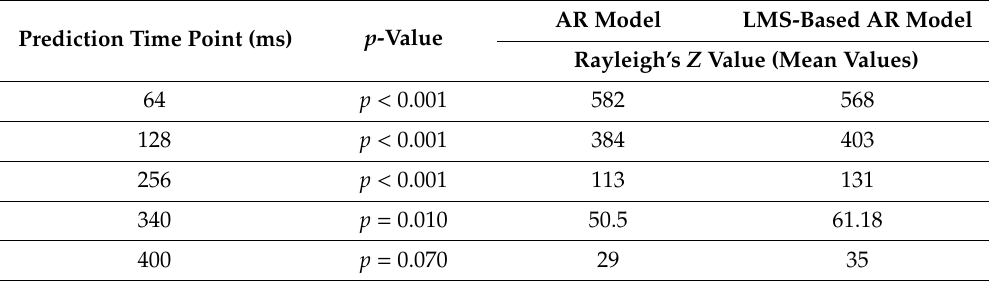
Table 2. Statistical comparison of Rayleigh’s Z value for channel O1 for 800 ms